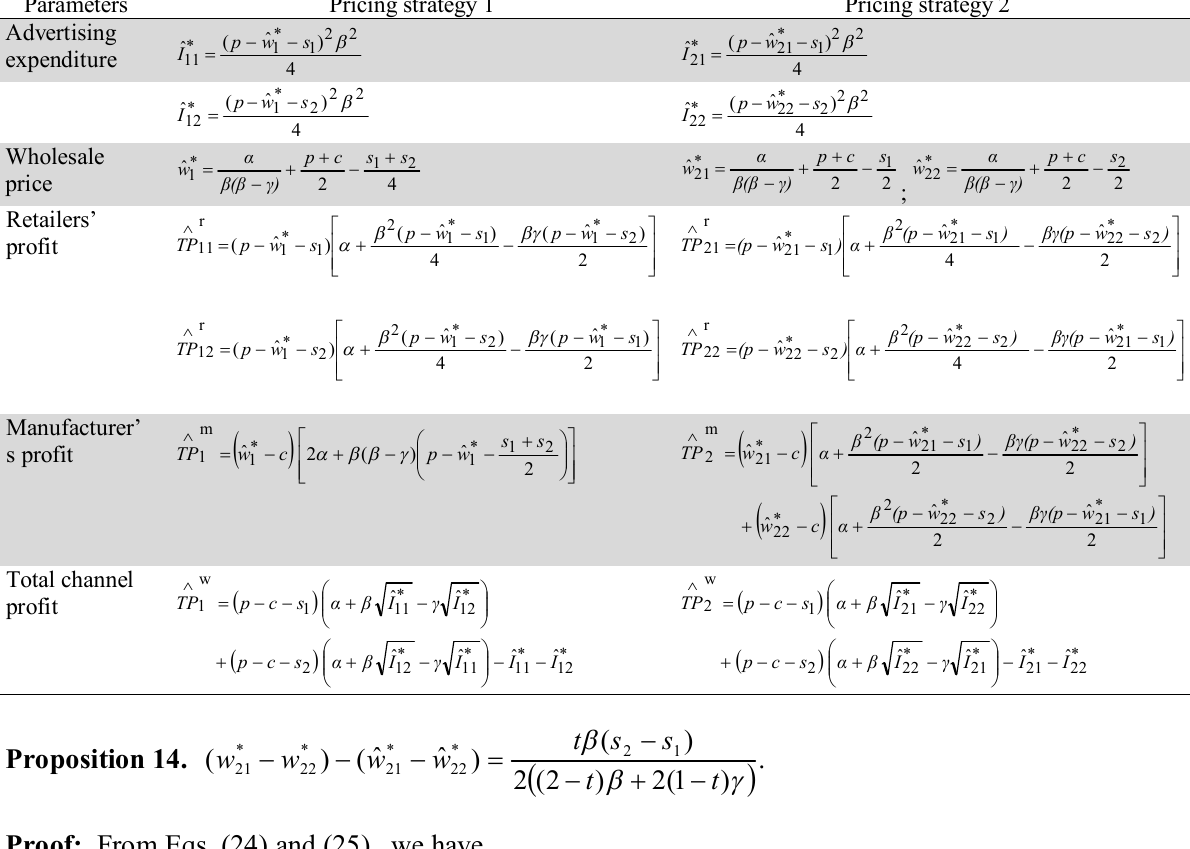
Optimal results when manufacturer does not adopt cooperative